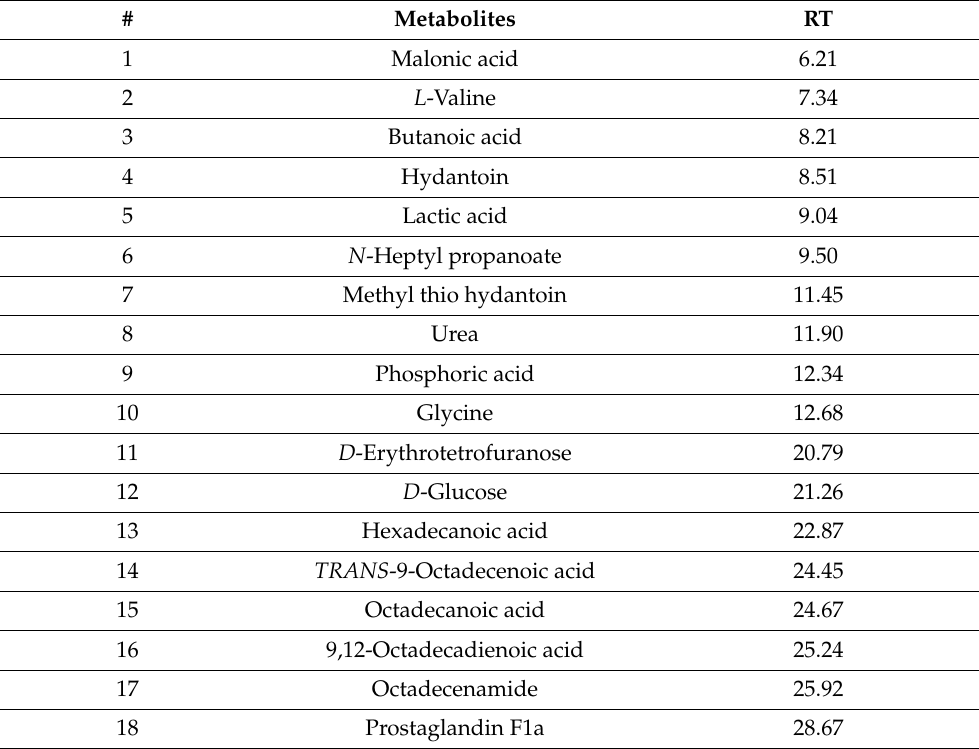
Table 2. Identified metabolites and their retention time using the gas chromatography technique. RT, retention